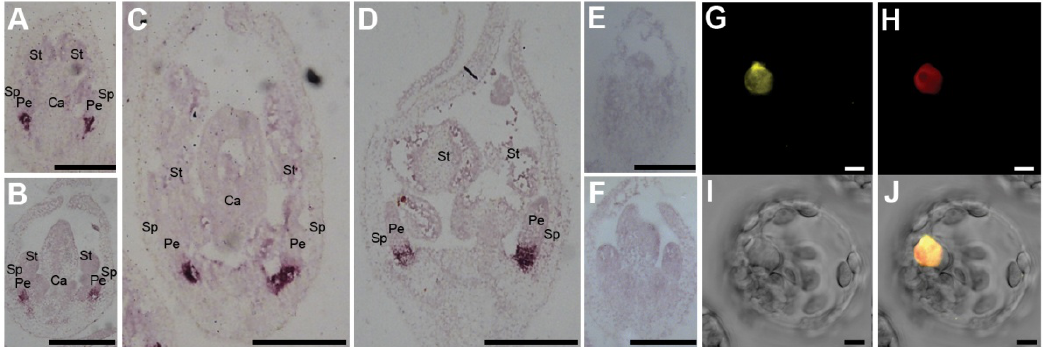
Figure 5. Spatiotemporal expression pattern and subcellular localization of SYP1. ( A , C ) SYP1 gene expression was detected in developing flowers. ( B , D ) COCH gene expression was detected in developing flowers. ( E,F ) The SYP1 and COCH sense probes were used as the negative controls. No hybridization signal was detected in developing flowers. St, Stamen; Sp, Sepal; Pe, Petal; Ca, Carpel. ( A – F ) Scale bars = 100 μm. ( G – J ) Subcellular localization of SYP1 fusion proteins in mung bean protoplasts by YFP or mCherry fluorescence. The fluorescent fusion proteins were expressed in mung bean protoplasts and visualized by confocal microscopy. ( G – J ) Subcellular localization analysis of SYP1-YFP together with the nuclear marker OsARF4-mCherry. The cells were analyzed for yellow fluorescence emission, mCherry fluorescence emission, and under bright-field illumination 12 h after transformation. Scale bar = 5 μm.